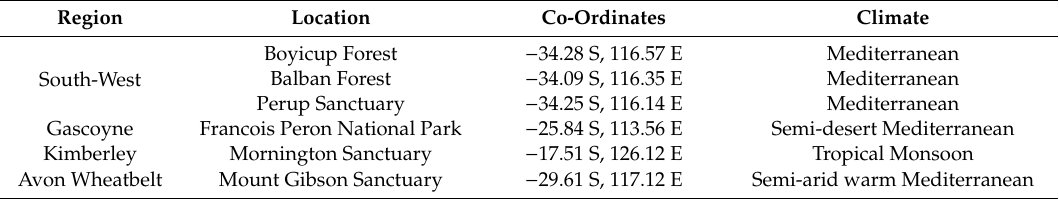
Table 1. The location details of the six study sites from which cat and by-catch trapping data were sourced.